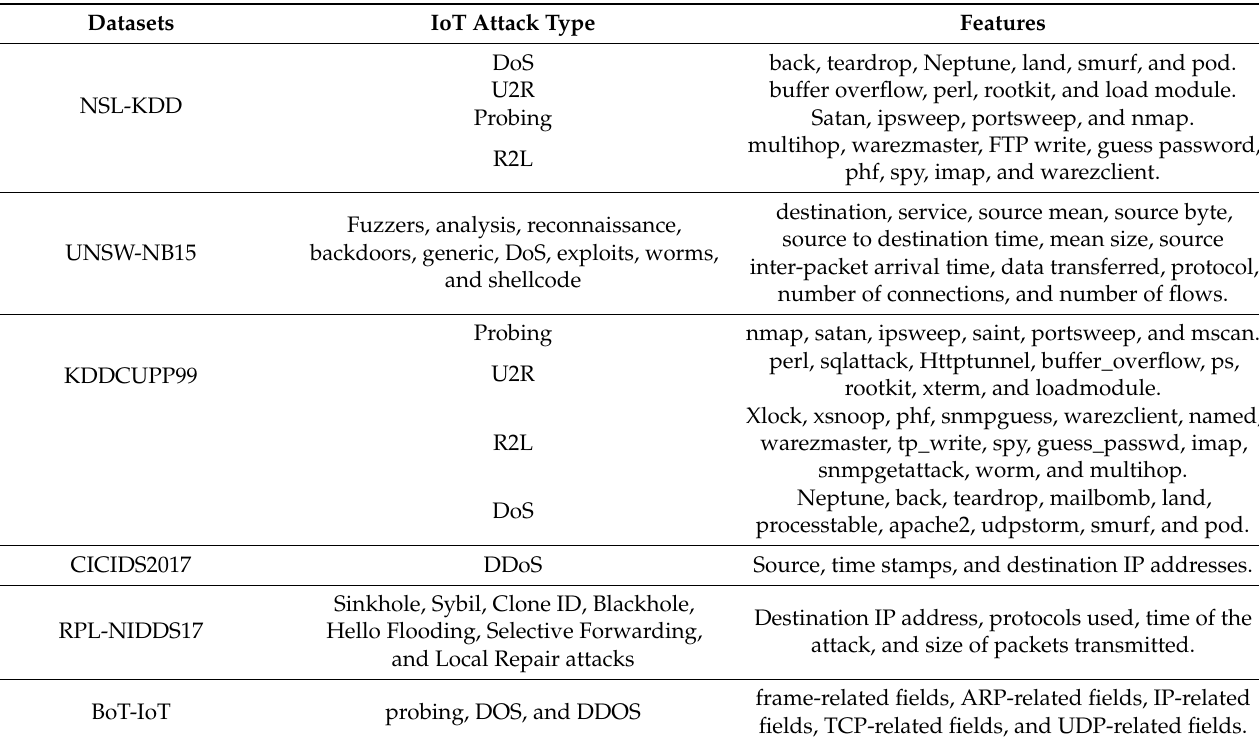
Table 10. Features considered in primary studies (public datasets).